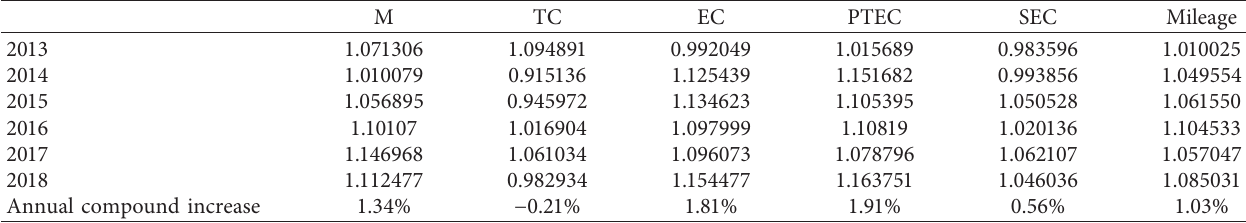
Table 1: Average operating efficiency and index decomposition of toll roads in 29 provinces (with 2010 as the base period). M